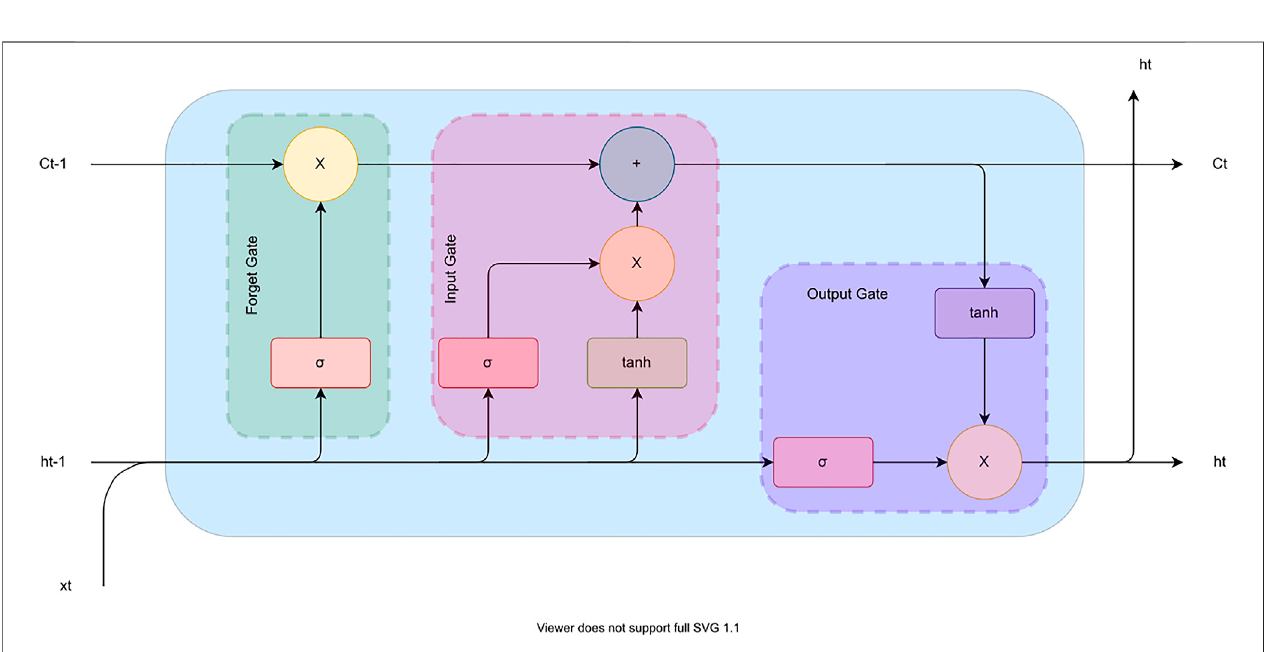
FIGURE 4 | The building block of